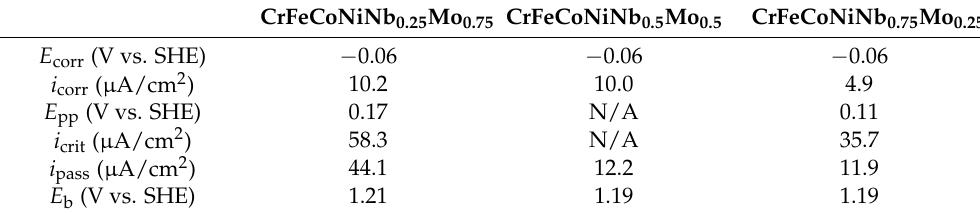
Figure 9. Potentiodynamic polarization curves of as-cast CrFeCoNiNb x Mo 1 − x alloys tested in the 1 M deaerated sulfuric acid solution at 30 ° C. Table 7. Potentiodynamic polarization data of the as-cast CrFeCoNiNb x Mo 1 − x alloys in 1 M deaerated H 2 SO 4 solution at 30 ° C.